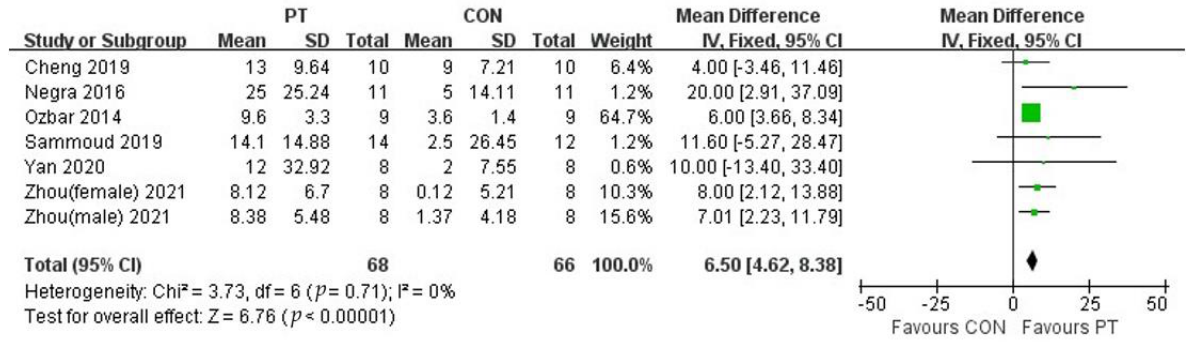
Figure 6. Forest plot of SLJ of experimental and control